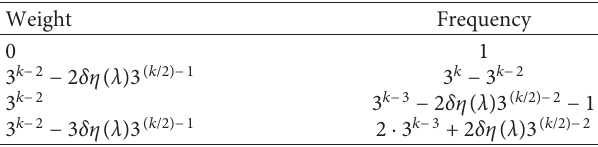
Table 8: Weight distribution of C